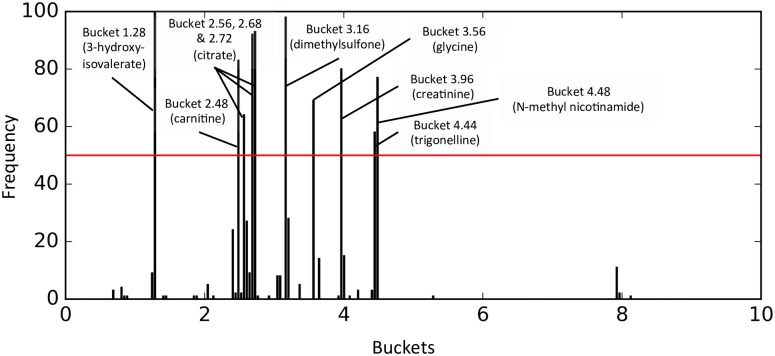
Buckets’ frequency over the 100 metabolomic global models.This figure shows the frequency (y axis) of each bucket selected over the 100 global models built on the metabolomic data (x axis). The red horizontal line corresponds to a frequency threshold of 50. Buckets with a frequency higher than this threshold are labeled with their corresponding metabolites.